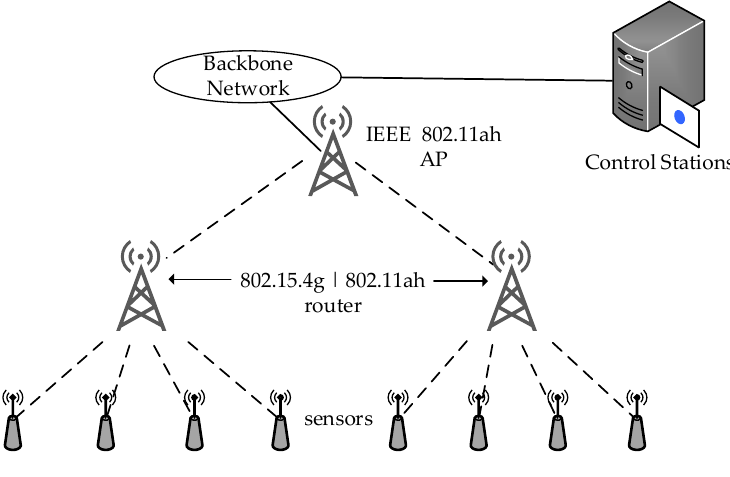
Figure 3. Wireless backhaul scenario of IEEE 802.11ah.